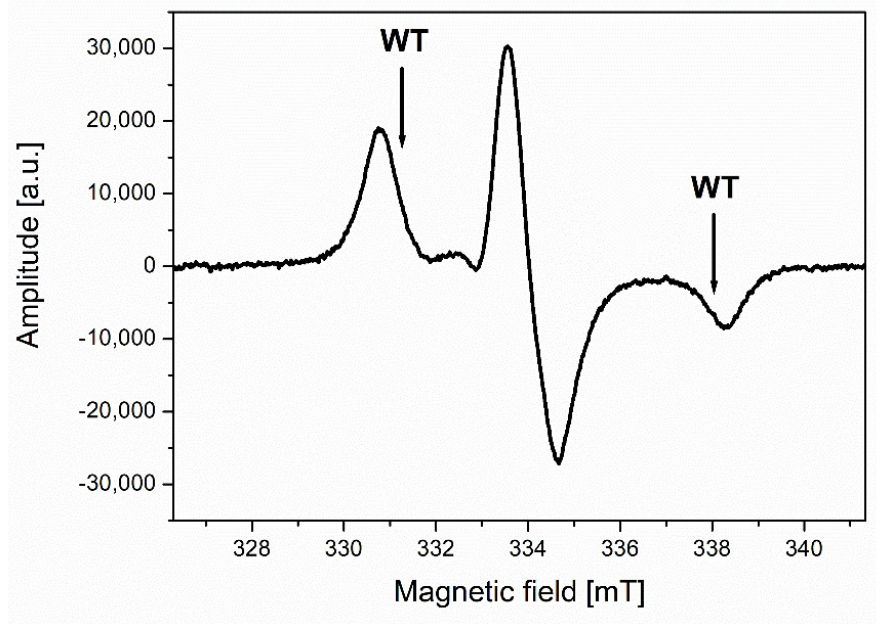
Figure 13. ESR spectrum (240 K) of TEMPOL spin probe (WT: wide triplet) measured after 15 min of incubation with HL-60 leukemia cells suspension (2.4 × 10 5 cells/mL).